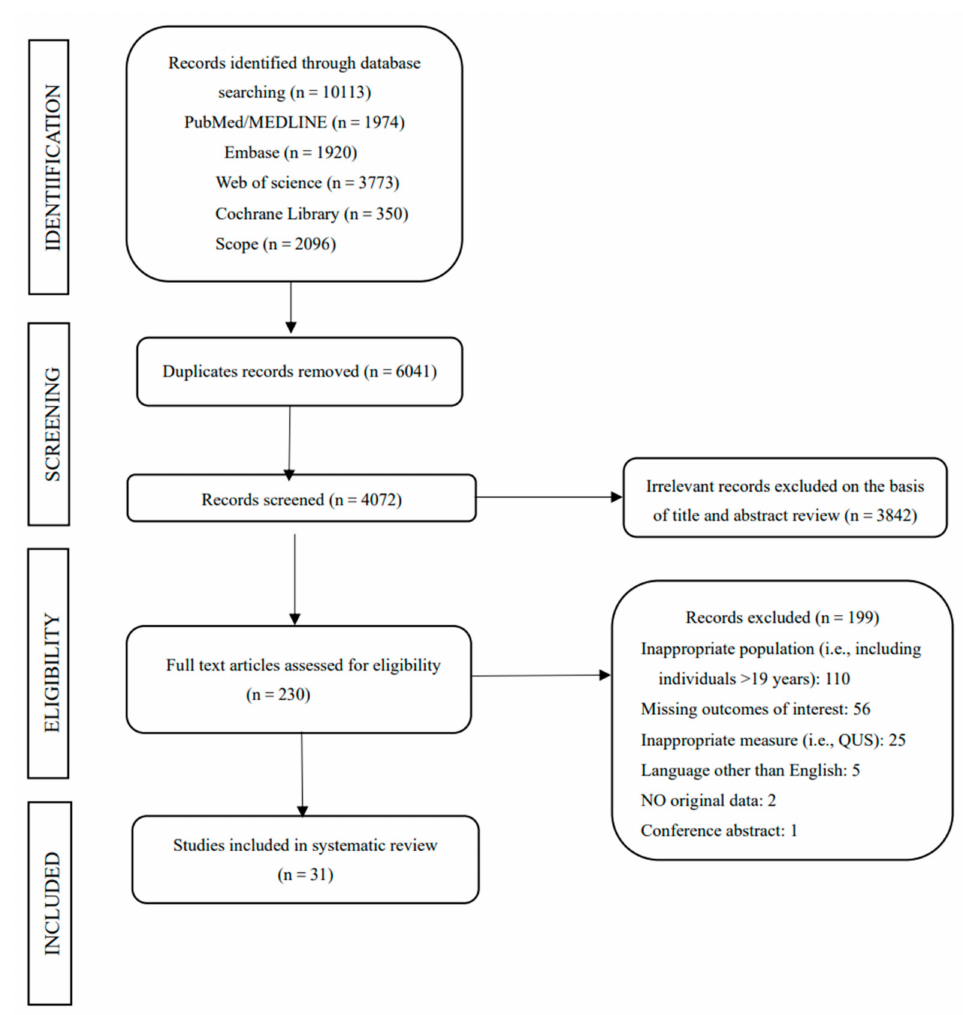
Figure 1. PRISMA flow